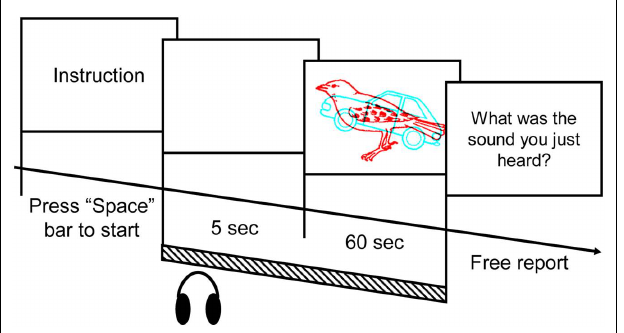
FIGURE 1 |The trial sequence in Experiment 1A. An example of the dichoptic stimulus pairs used in the present study is demonstrated in the third frame.The soundtrack was presented from the start of the blank fame until the end of the visual stimuli (i.e., for a total of